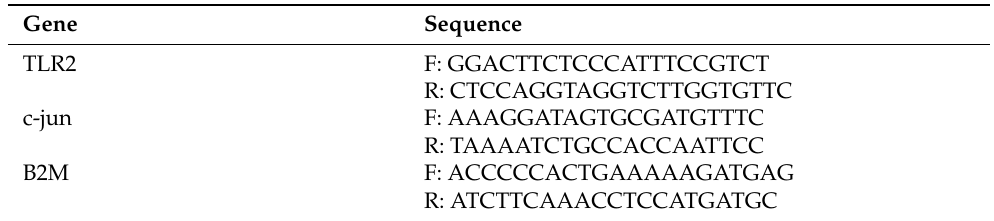
Table 2. Primers used in this